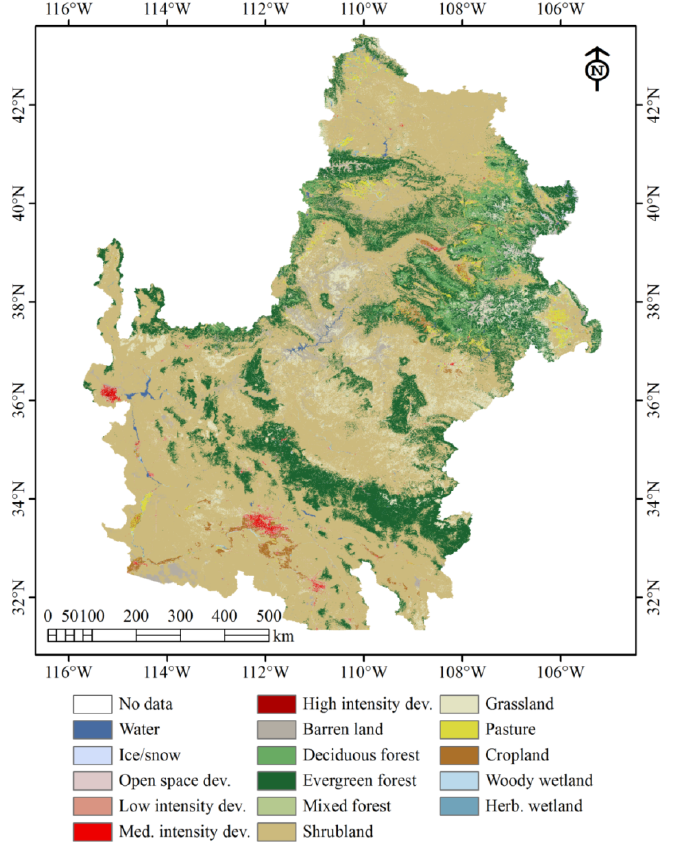
Figure 2. Land use/land cover distribution in the Colorado River Basin based on National Land Cover Database 2006